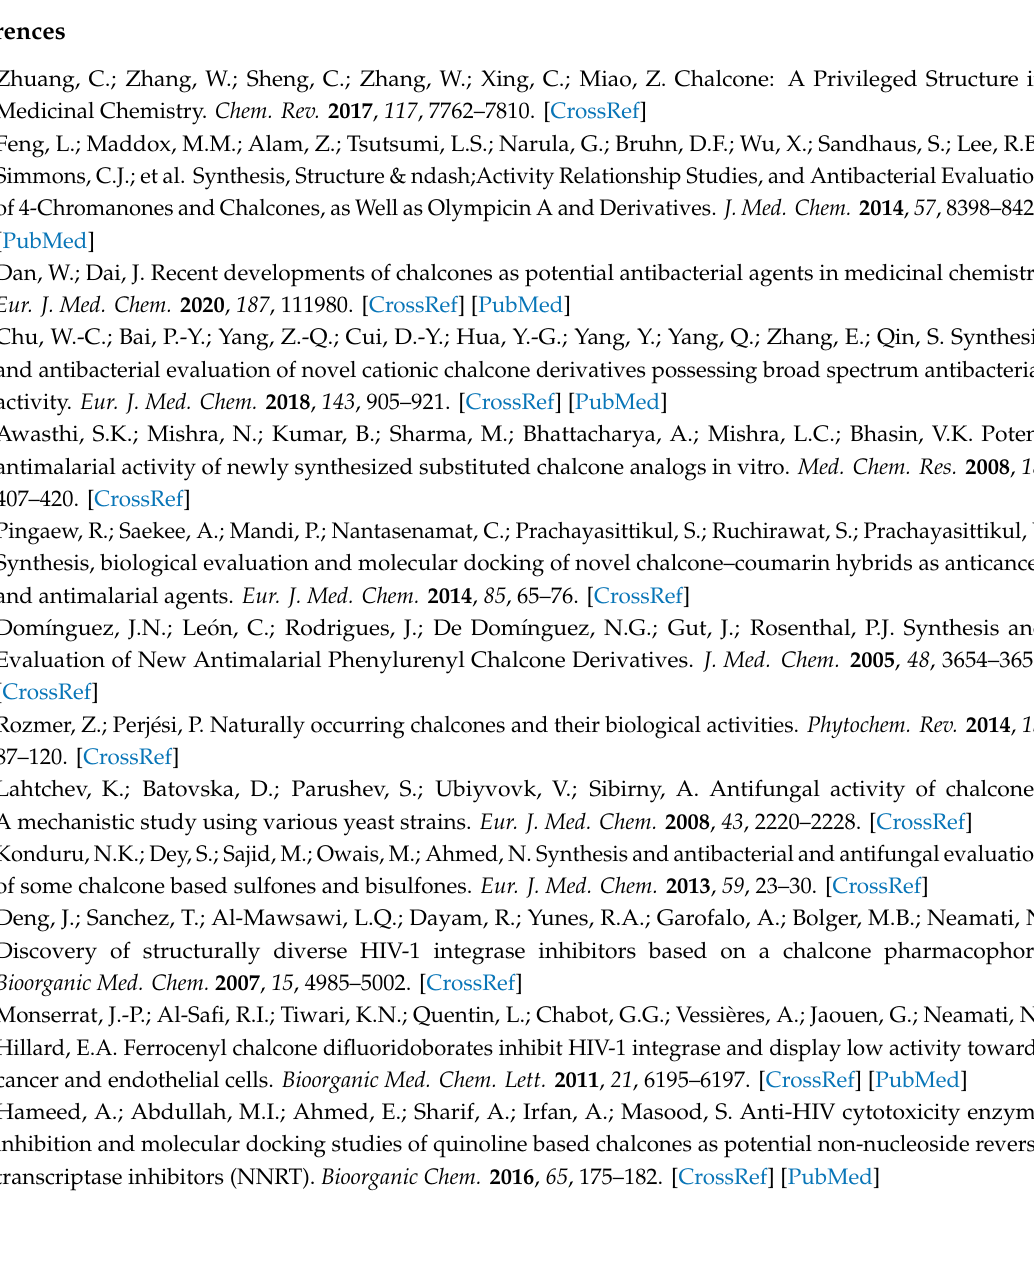
HR-MS of compound 13m , Figure S39: 1 H NMR of compound 13n (DMSO- d6 , 400 MHz), Figure S40: 13 C NMR of compound 13n (DMSO- d6 , 400 MHz), Figure S41: HR-MS of compound 13n